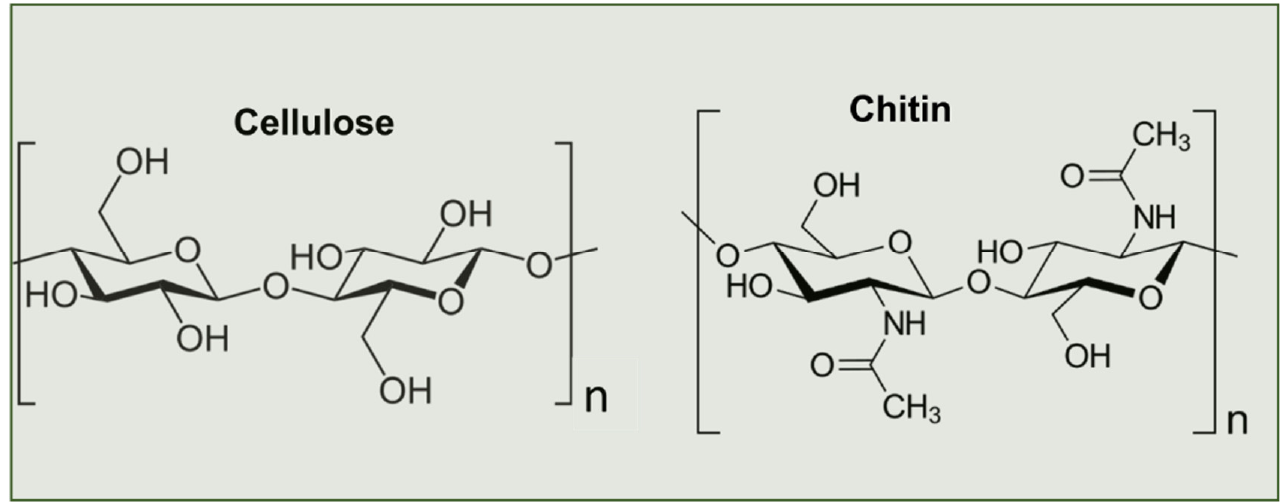
Figure 1. Structures of cellulose and chitin. The chitin biosynthesis pathway is highly conserved in all organisms, from algae to crus- taceans and from fungi to insects. As summarized in Figure 2, chitin biosynthesis pathway can be generally divided into five distinct phases namely; (1) synthesis of N -acetylglucosamine- 6-phosphate from sugars such as glucose, glycogen or trehalose via the hexosamine path- way [75], (2) synthesis of amino sugar uridine diphosphate N -acetylglucosamine-(UDP- N - acetylglucosamine), (3) polymerization UDP- N -acetylglucosamine by the action of chitin synthase into chitin and (4) deposition of chitin along the cell membrane and release into the extra-cellular space and finally, (5) assembly into chitin nanofibrils [76–78]. As elegantly sum- marized in previous reports [76–78] and shown in Figure 2, trehalose is first converted into glucose by trehalase, and the glucose is further converted into glucose-1-phosphate by phos- phorylase. The formed glucose-1-phosphate is then converted into glucose-6-phosphate